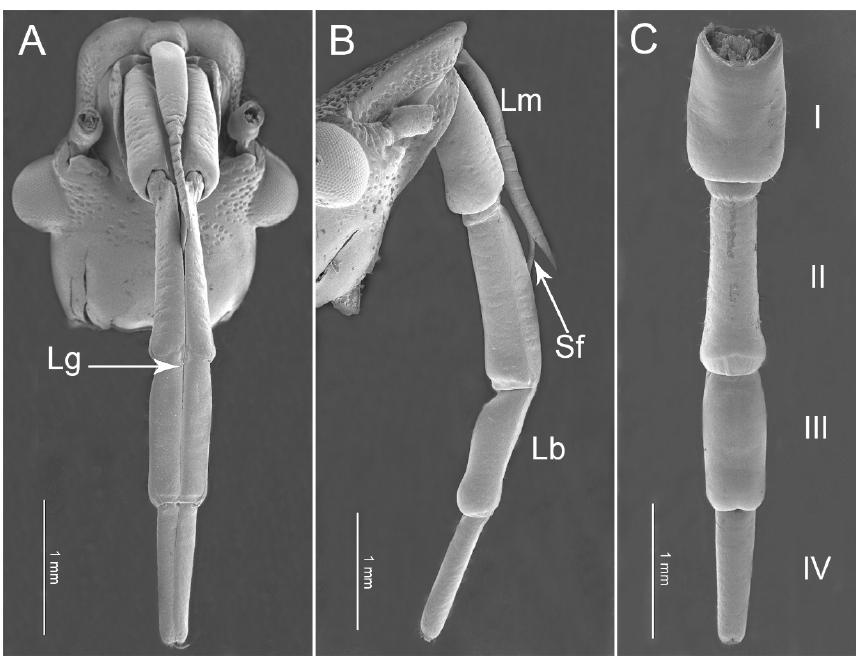
Figure 1. Scanning electron micrographs of the head of Picromerus lewisi . ( A ) Ventral view; ( B ) Lateral view; ( C ) Dorsal view showing four-segmented labium (I–IV); Lg, labial groove; Lm, labrum; Lb, labium; Sf, stylet